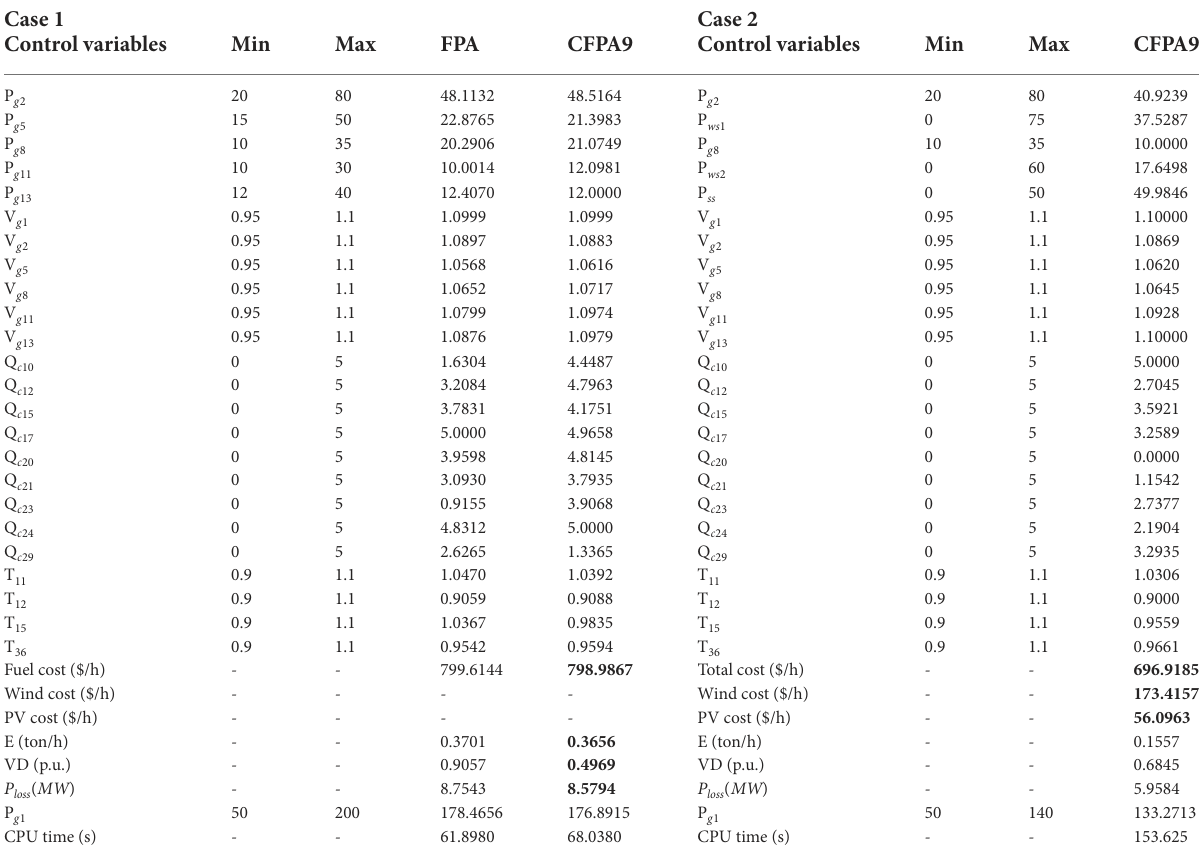
TABLE 8 Findingsforcase1andcase2(IEEE30-bus).